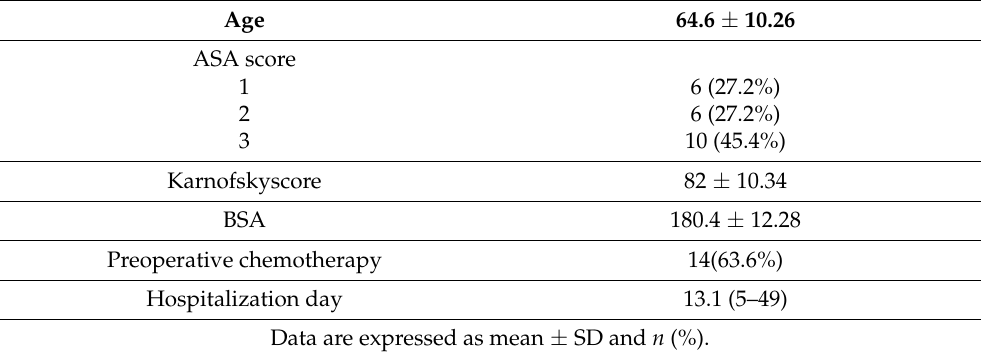
Table 1. Demographic data of patients.